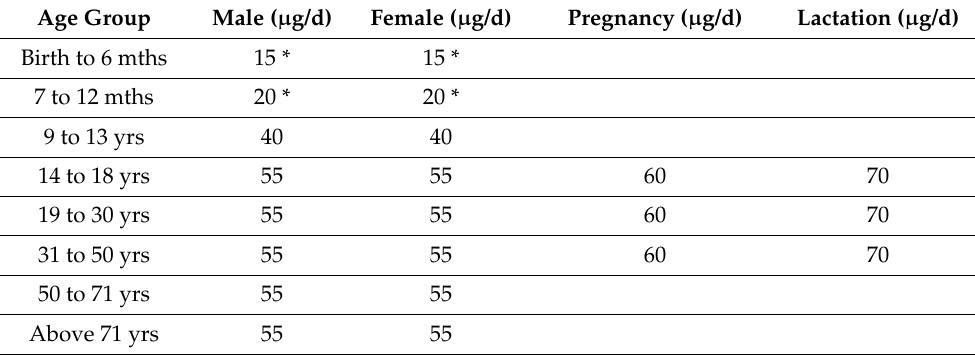
Table 2. Recommended daily intakes of selenium for individuals in different age groups and genders. The Adequate Intake (AI) is equivalent to the mean selenium intake of healthy, breastfed infants from birth to 12 months of age, as established by the Food and Nutrition Board (FNB) [13].